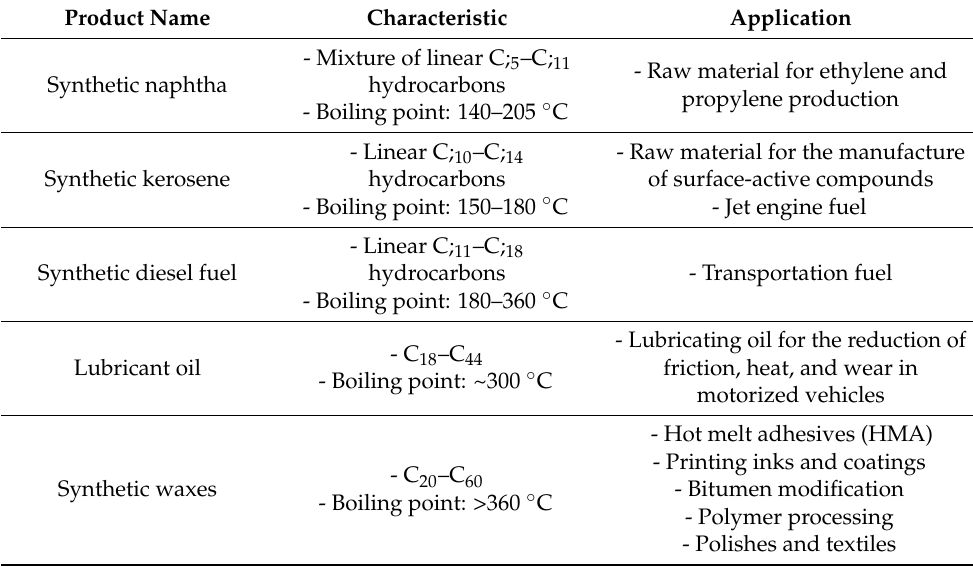
Table 2. Characteristics and applications of FTS